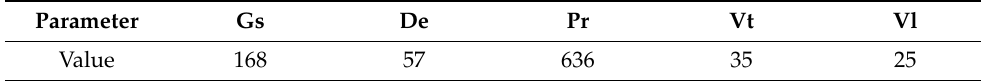
Table 3. Results of the multi-objective optimization in the rough honing operation.